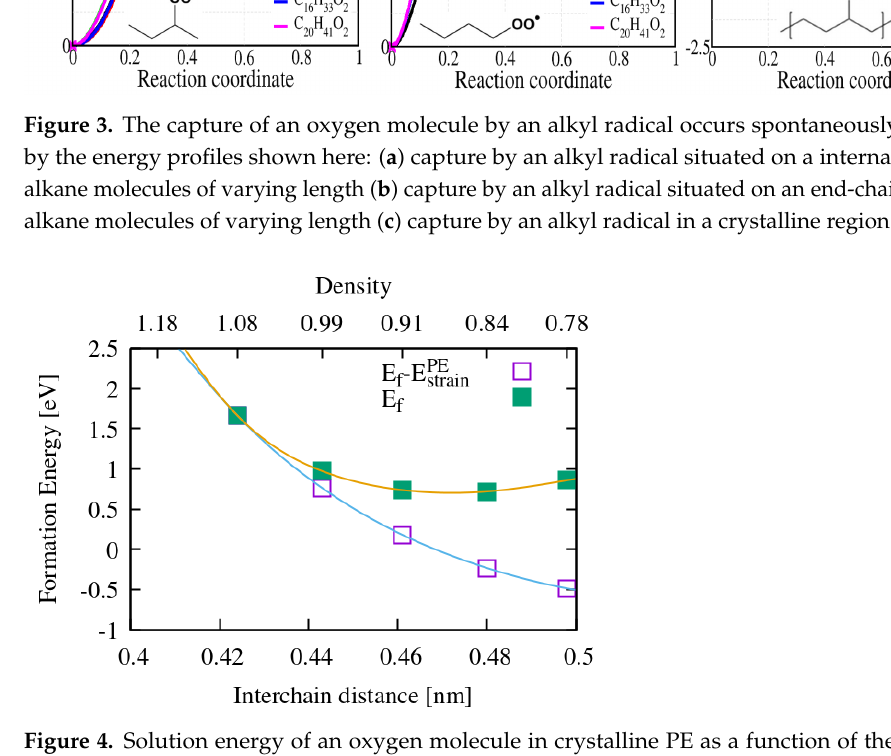
). The oxygen strain